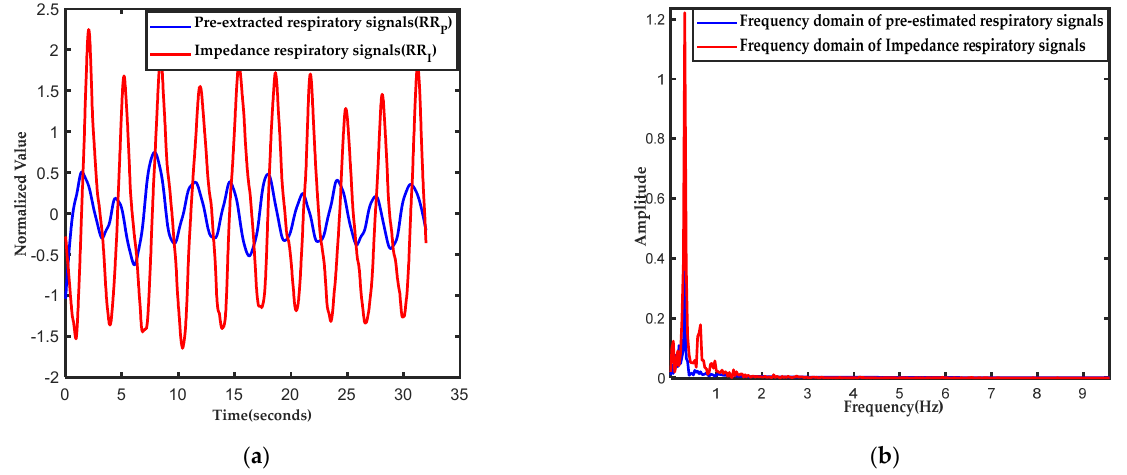
Figure 3. ( a ) Time domain comparison of impedance respiratory signals with pre ‐ extracted respiratory signals based on the EEMD ‐ PCA method. ( b ) Frequency domain comparison of impedance respiratory signals with pre ‐ extracted respiratory signals based on the EEMD ‐ PCA method. The blue line represents the pre ‐ extracted respiratory signals in the time ‐ frequency domain, and the red line represents the impedance respiratory signals in the time ‐ frequency domain.